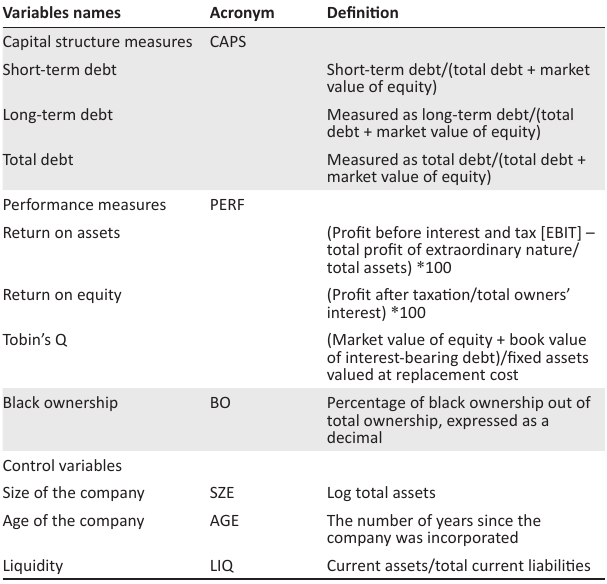
TABLE 1: Definition of